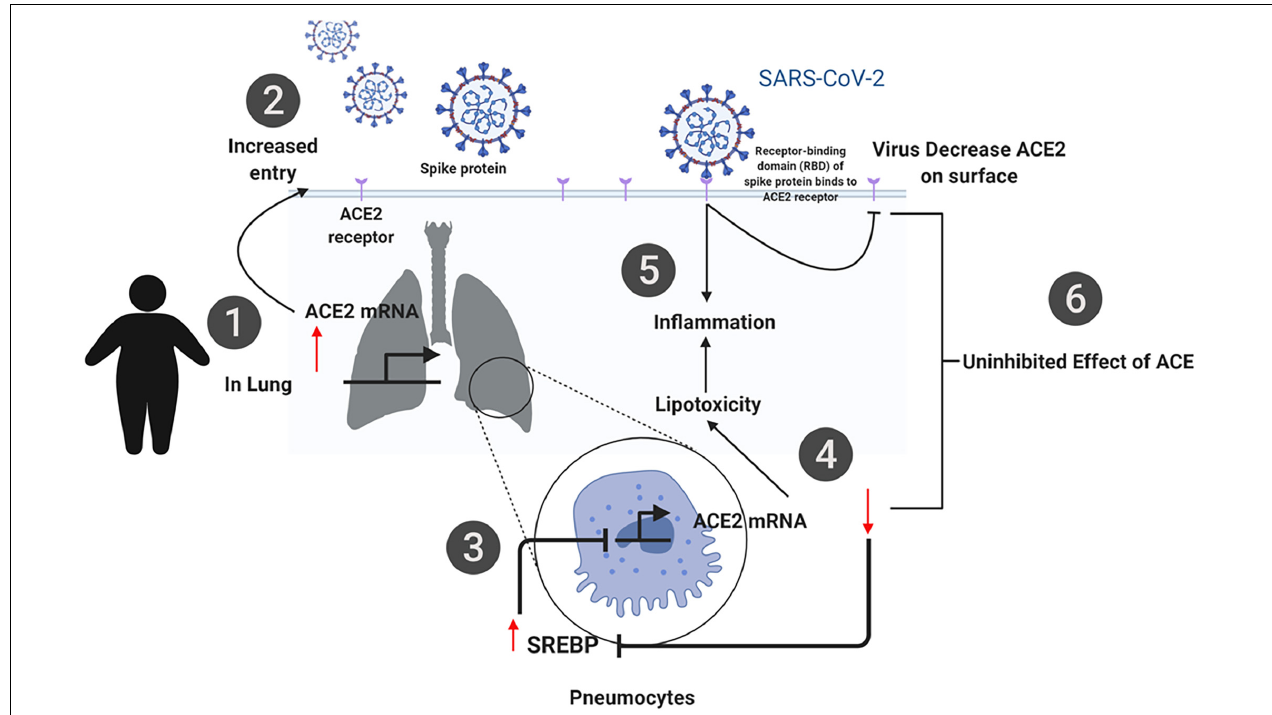
FIGURE 10 | Summary of the proposed mechanism of SARS-CoV-2 infection in obese individuals. (1) ACE2 expression is increased in obese subjects due to dysregulation in lipid metabolism. (2) Increased ACE2 expression leads to an increase in the viral entry of SARS-CoV-2, which utilizes ACE2 as a receptor. (3) Upon entry of the virus, dysregulation in lipid metabolism leads to an increase in SREBP, which subsequently leads to a decrease in ACE2 (4). (5, 6) Inhibition of ACE2 activity results in increased lipotoxicity and inflammation. This mechanism demonstrates the dual function of ACE2 in viral